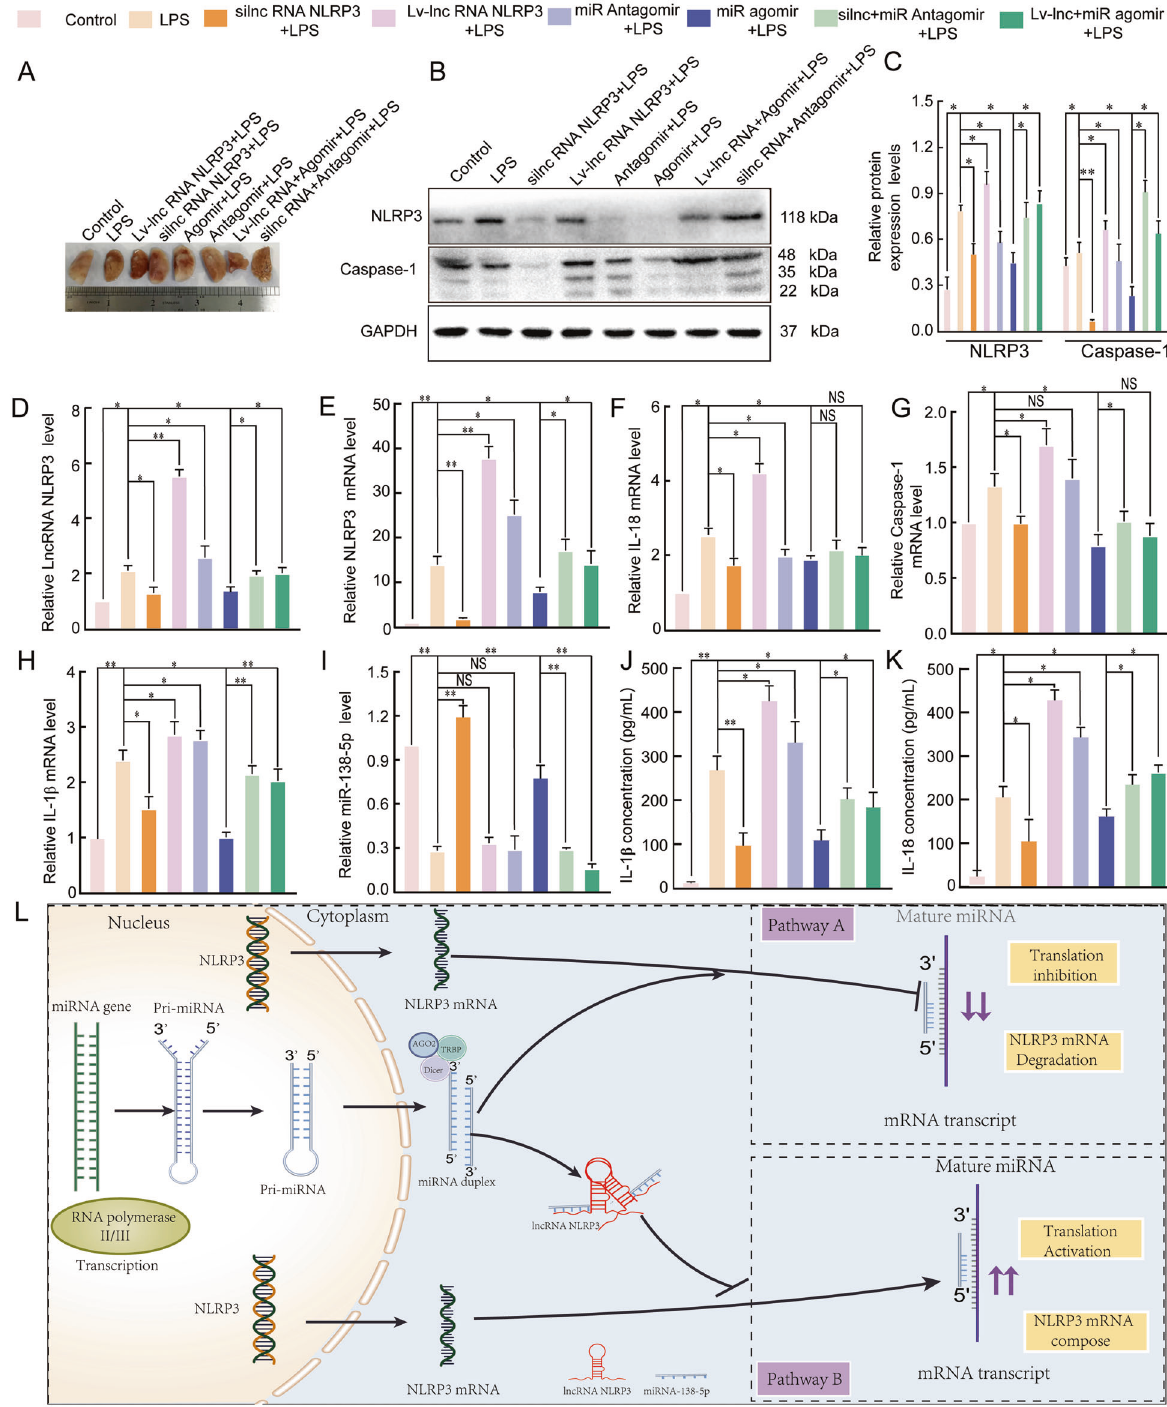
Fig. 8 The mechanism by which the lncRNA NLRP3/miR-138-5p/NLRP3 ceRNET functions in the in fl ammatory response. The lungs of rats were injected with PBS in the control group and LPS-treated rats were further treated with si-r-lncRNA NLRP3, Lv-lncRNA NLRP3, agomiR-138- 5p, antagomiR-138-5p, Lv-lncRNA NLRP3 + agomiR-138-5p, and si-r-lnc NLRP3 + antagomiR-138-5p. A Morphometric changes in the appearance of the lungs that had been fi xed in 4% paraformaldehyde for 24 h at 25 °C in each group. B , C The protein expression levels of NLRP3 and caspase-1 in rat lung tissues. qRT-PCR assays were used to analyse mRNA expression of D lncRNA NLRP3, E NLRP3, F IL-18, G Caspase-1, H IL-1 β , and I miR-138-5p in the lung tissues of rats. ELISA analysis of the IL-1 β ( J ) and IL-18 ( K ) levels in the culture supernatant. L Graphical summary of the role of the lncRNA NLRP3/miR-138-5p/NLRP3 ceRNET in acute lung injury. β -Actin was used as the reference. The data are presented as mean ± SE ( n = 6). * P < 0.05; ** P < 0.01; *** P < 0.001; NS, no statistically signi fi cant difference.